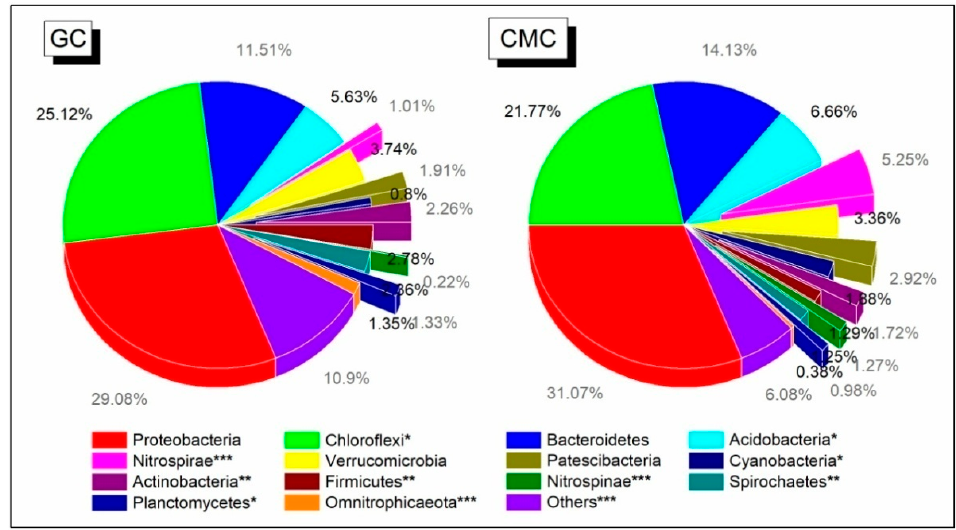
Figure 5. Relative abundance of the dominant bacterial phyla for pond sediments separately according to aquaculture practices. See Figure 1 for abbreviations. * p < 0.05; ** p < 0.01; *** p < 0.001.